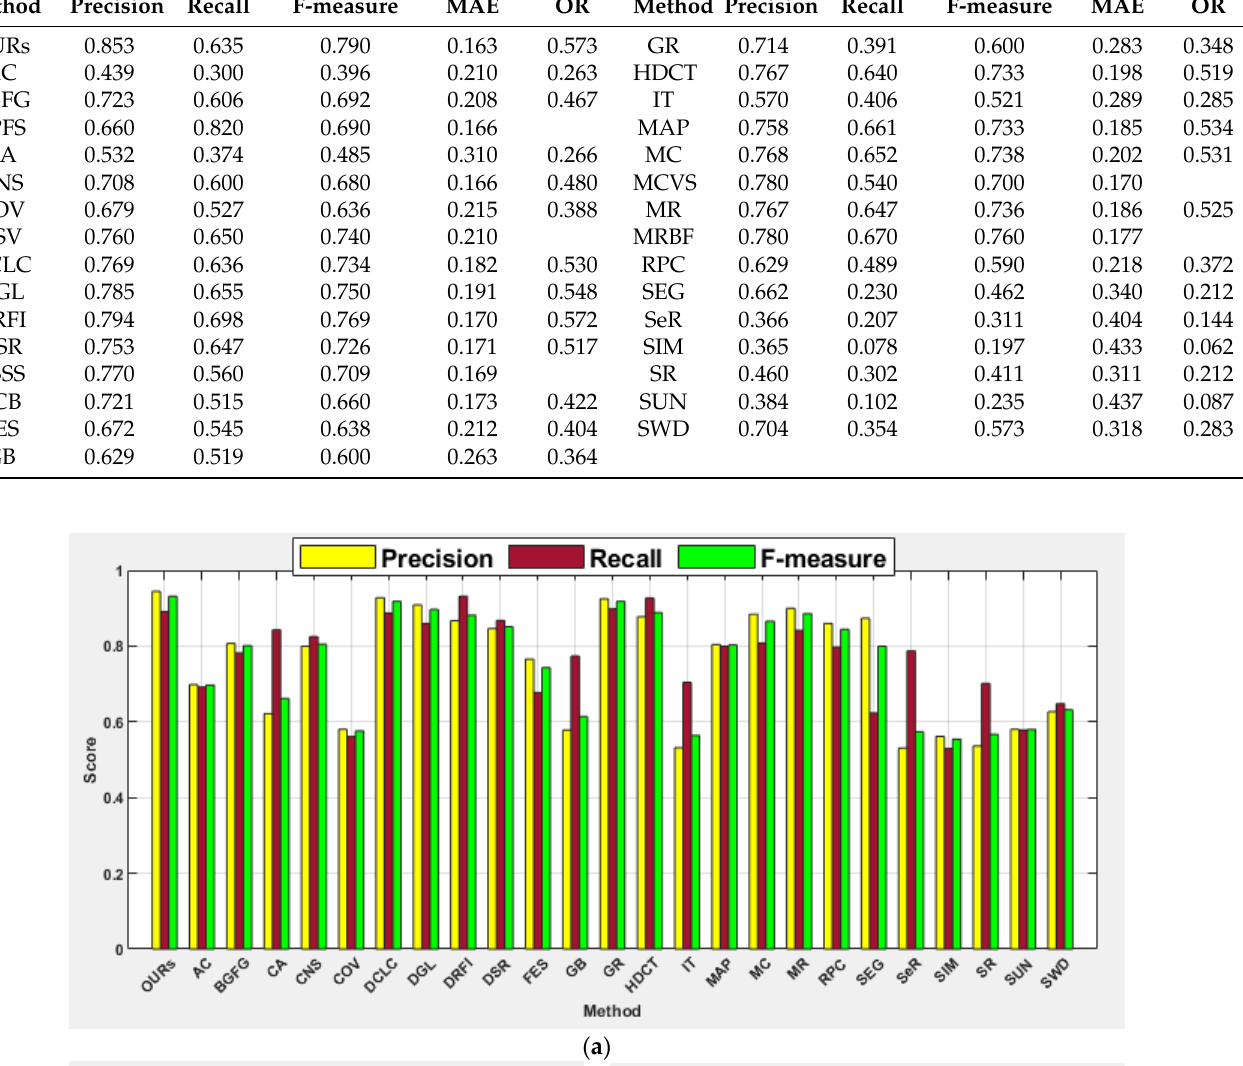
Table 3. Performance statistics on ECSSD dataset in terms of precision, recall, F-measure, MAE and OR. Method